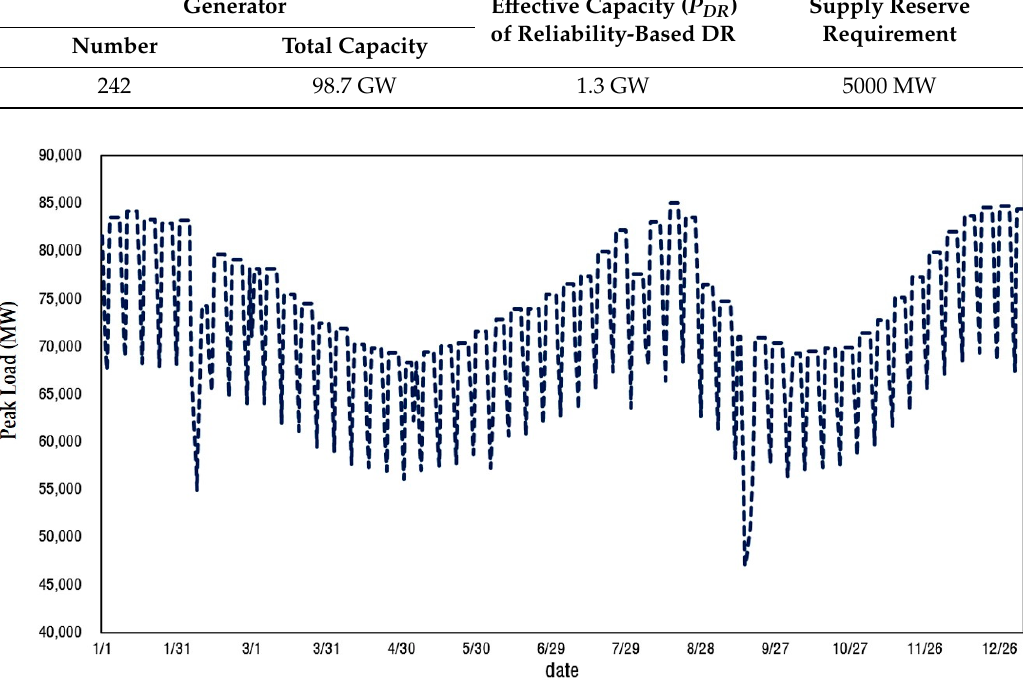
Figure 2. Forecasted daily peak load.